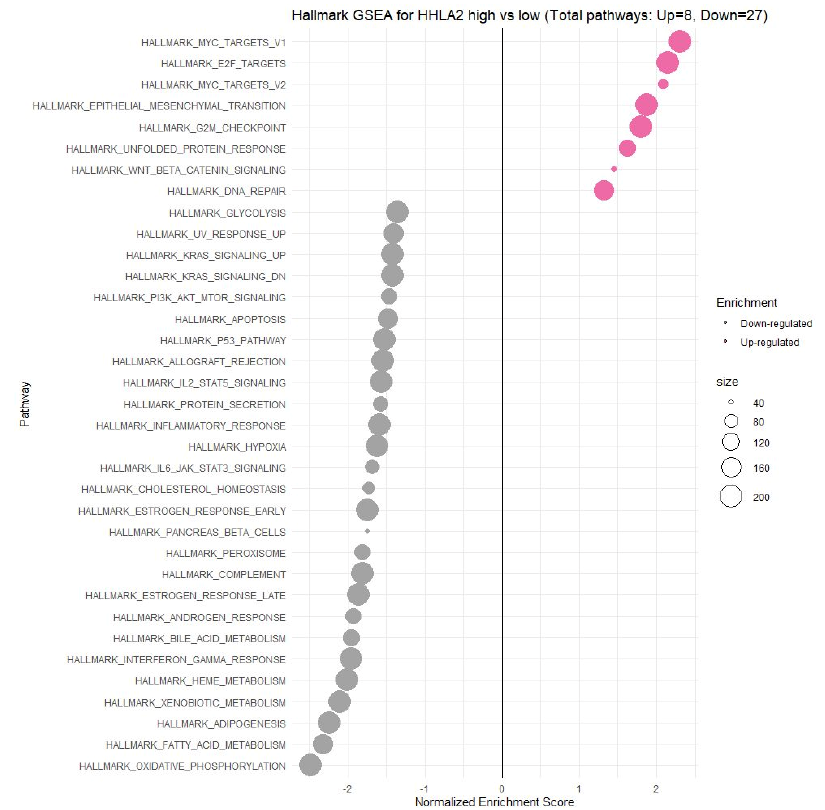
Figure 13. Gene set enrichment analysis (GSEA). The most involved significant hallmark correlated with HHLA2 in CRC. NES: normalized enrichment score.